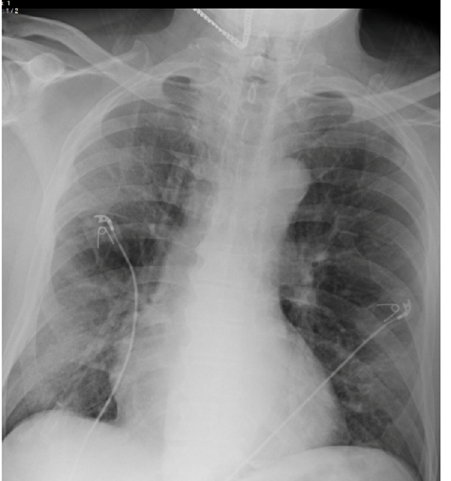
Figure 3. Unilateral–multilobar—hazy infiltrates throughout the right lung.